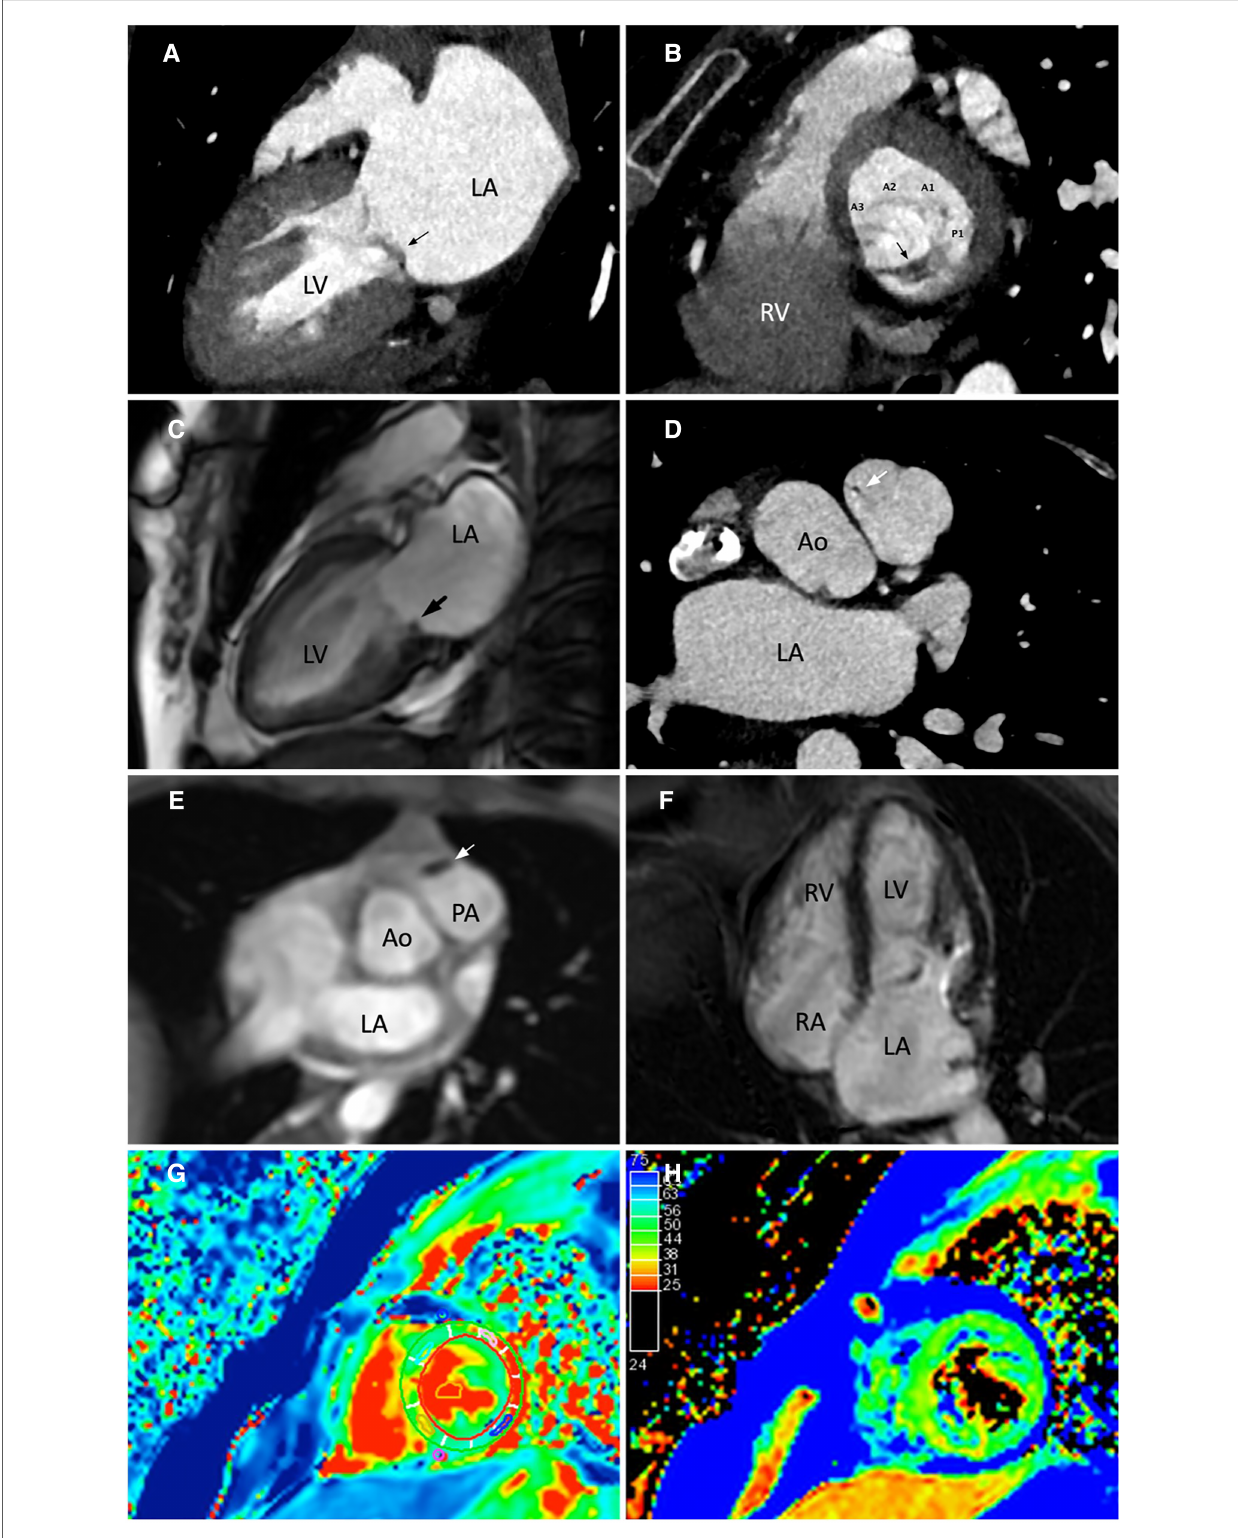
FIGURE 2 Evaluation of the mitral and pulmonary valve vegetations using cardiac computed tomography (CT) and cardiac magnetic resonance (CMR). ( A,C ) CT 2- chamber view and cine-CMR still image in end-systole showing a non-homogeneous, isodense mass involving the posterior lea fl et of the mitral valve. ( B ) CT short axis view of the mitral valve from a basal short axis slice demonstrated the attachment of the vegetation to the P2 and P3 portions of the posterior mitral lea fl et. The mitral valve was seen from a left ventricular perspective. ( D,E ) Transverse CT and CMR images through the right ventricular out fl ow tract showed a small oscillating mass on the anterior cusp of the pulmonary valve. ( F ) The myocardium showed no late gadolinium enhancement. ( G,H ) Normal fi ndings on native-T1 and T2-weighted mapping images. Annotations: LA, left atrium; LV, left ventricle; RA, right atrium; RV, right ventricle; Ao,